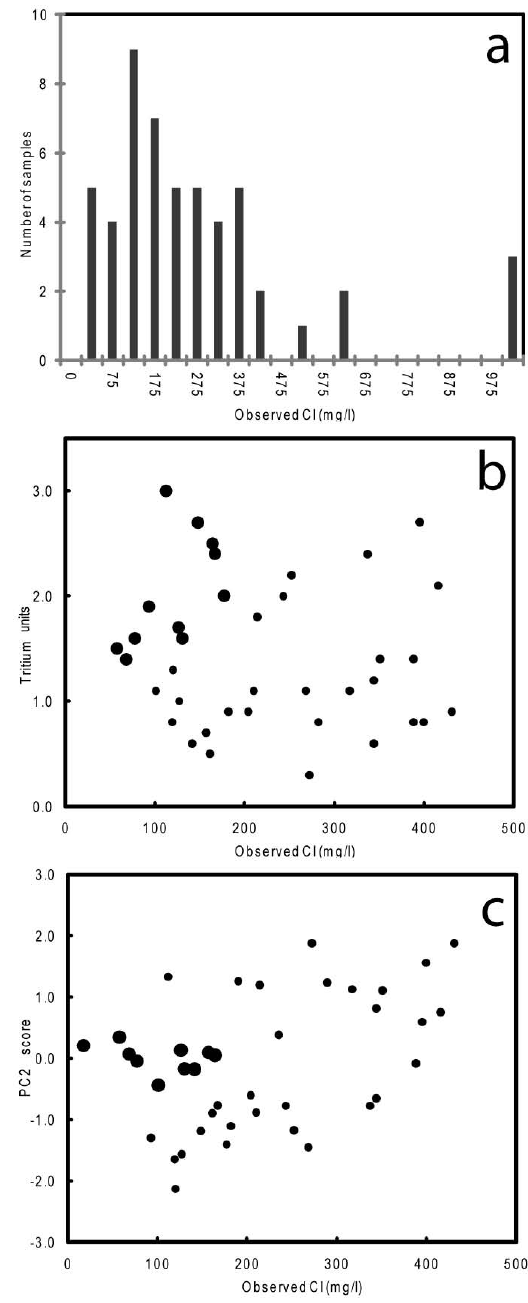
Fig. 9. Three methods to estimate average chloride concentration of recent net water-table recharge for catchment 8: (a) histogram of observed groundwater chloride concentration data, (b) tritium vs. groundwater chloride concentration, and (c) the score of second principal component (PC2) of the concentration data of eight major ions, vs. sample chloride concentration. In (a), data points to the left of the mode (125mgl − 1 ) are selected to calculate the geometric mean, with a few concentration data below 10mgl − 1 are excluded. In (b) and (c), the data points marked with the larger symbols are